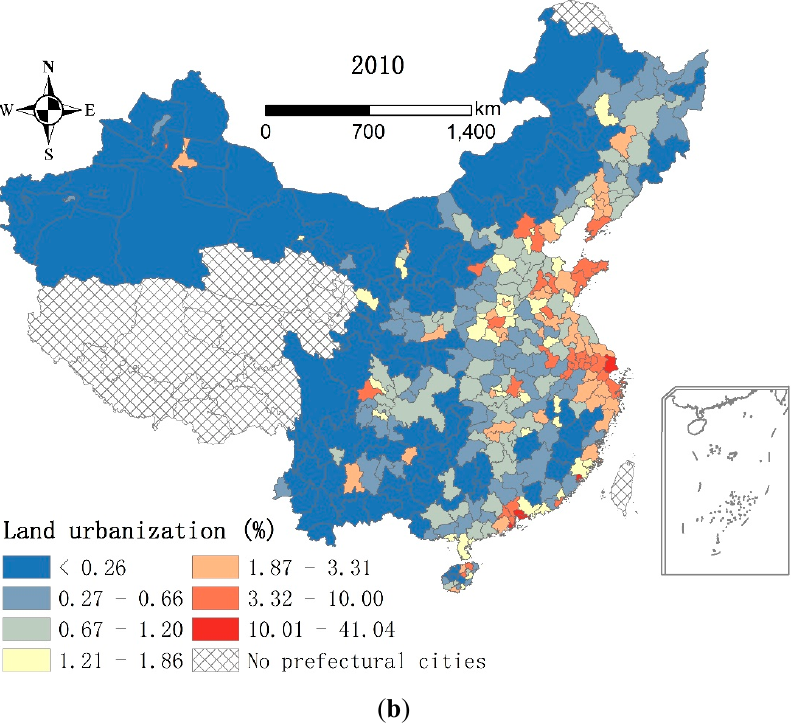
Figure 6. Land urbanization in the prefectural cities, China, 2000 and 2010. ( a ) Land urbanization in the prefectural cities, China, 2000; ( b ) Land urbanization in the prefectural cities, China, 2010.